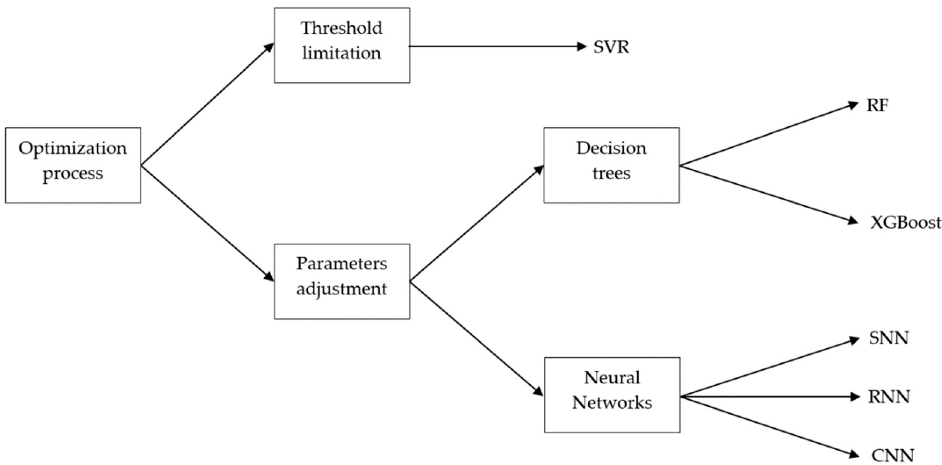
Figure 1. Phase diagram for the application of the Artificial Intelligence methods according to the optimization process.